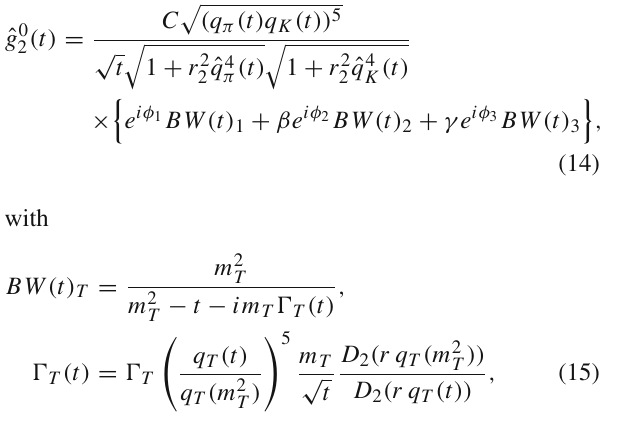
Table 2 Parameters of the g 0